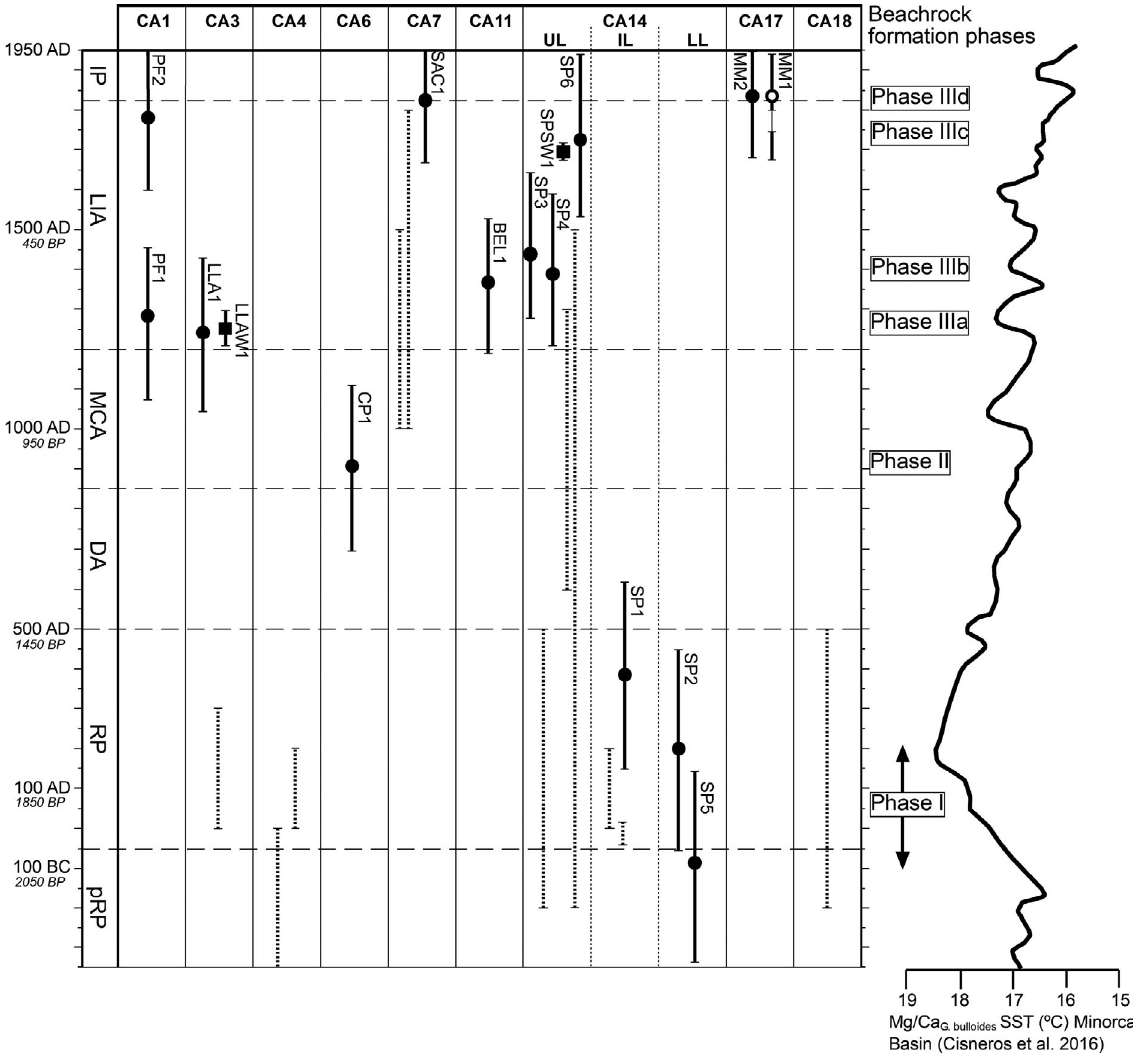
Fig. 9. – Chronology of beachrocks based on 14 C and OSL ages and formation phases for the study area. The time span for each sample is plotted. Black circles, median probability date for 14 C seashells. White circles, median probability date for 14 C charcoals. Black squares, median probability date for OSL samples. Black dotted lines, time span for anthropic remains. Climatic periods: pRP, pre-Roman Period; RP, Roman Period; DA, Dark Age; MCA, Medieval Climate Anomaly; LIA, Little Ice Age; IP, Industrial Period (Date intervals after Margaritelli et al. 2018). SST variation derived from Mg/Ca after Cisneros et al. G. bulloides